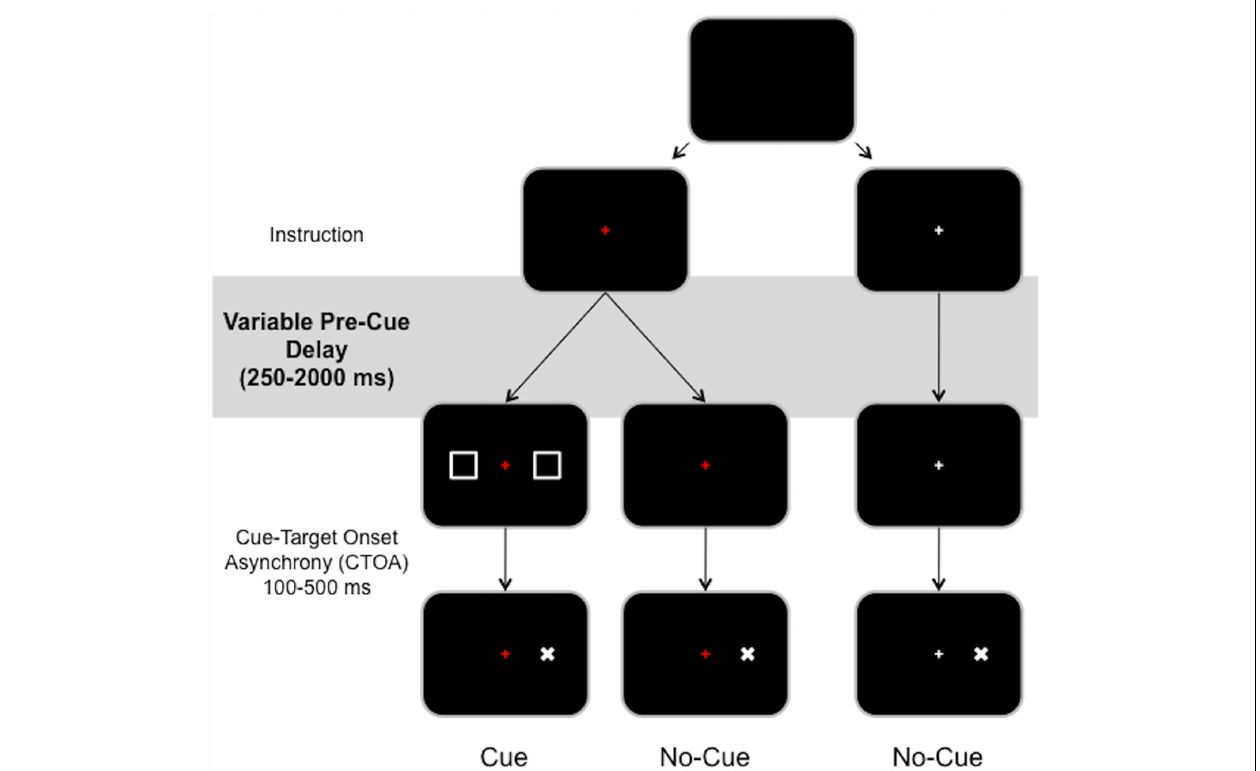
cannot be presented before target occurrence. In the former condition, subjects must refrain from reacting in order to avoid responses to the warning cue. In the latter condition, subjects can react automatically to any upcoming